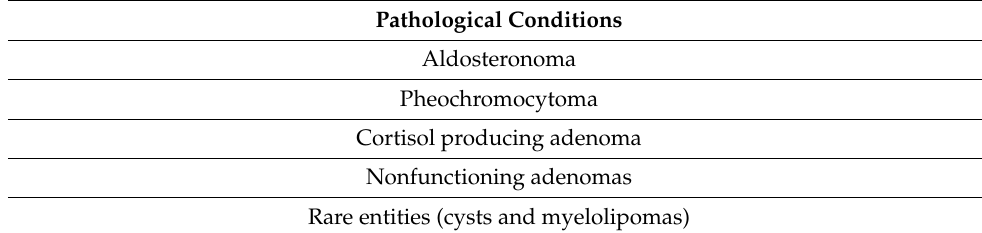
Table 2. Indications for